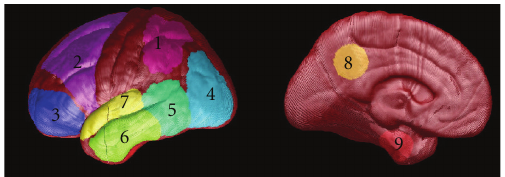
Figure 3: Generalized image of the VOIs used to extract FDDNP data. (Reprinted from Protas et al. 2010